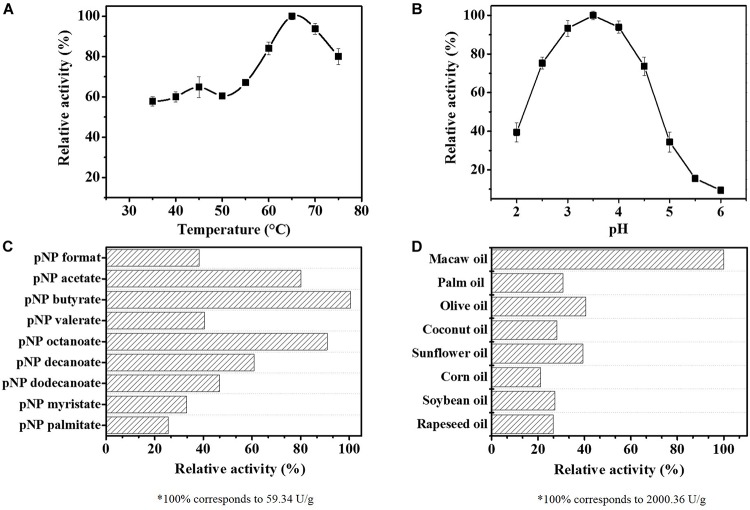
Effect of temperature (A) and pH (B) on the activity of the purified lipase from Rasamsonia emersonii (ReLip). The temperature effect was evaluated from 35°C to 75°C, at pH 4.0, while pH influence was assessed at 65°C using different buffers (pH 2.0 to 6.0). (C)
ReLip specificity against synthetic substrates (pNPs) with different chain lengths (65°C, pH 3.5, incubated for 20 min); 100% of activity corresponds to 59.34 U/g. (D) Hydrolytic activity of ReLip using different vegetable oils (5 wt%, 60°C, pH 4.0, incubated for 5 min); 100% of activity corresponds to 2,000.36 U/g. All measurements were conducted in triplicate. The relative activity (%) was calculated considering the maximum catalytic activity observed for the biological unit of the enzyme, and the specific activity was defined as the number of units per g of protein.